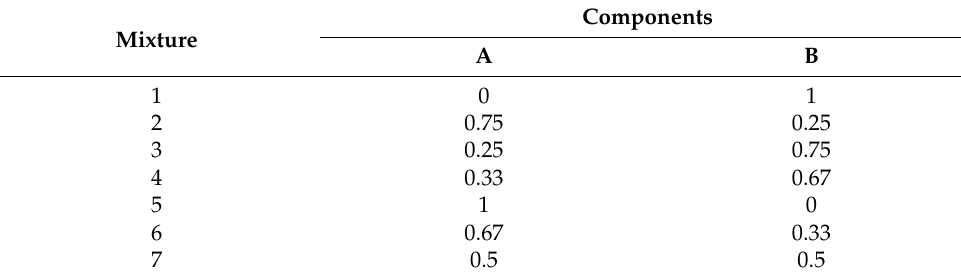
Table 2. The seven experiments selected for each binary mixture.